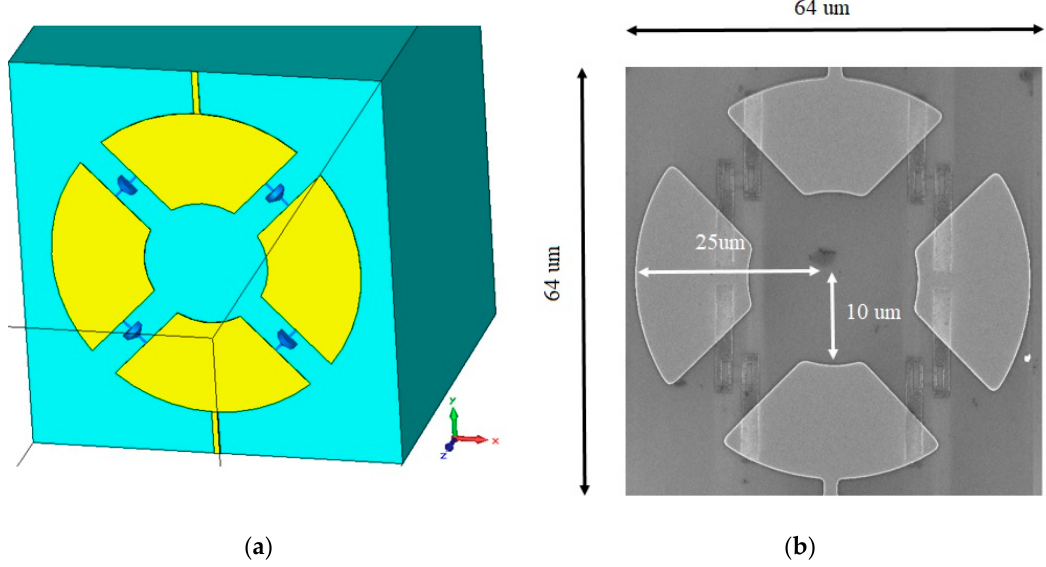
Figure 2. Unit cell of the CEB array: ( a ) 3D model with lumped elements representing CEBs [14], ( b ) SEM-image.